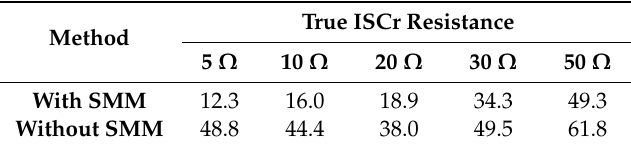
Table 3. Relative error (%) of the final value of R ISCf depending on the ISCr faults in the experiment with cell A and UDDS 5 A.